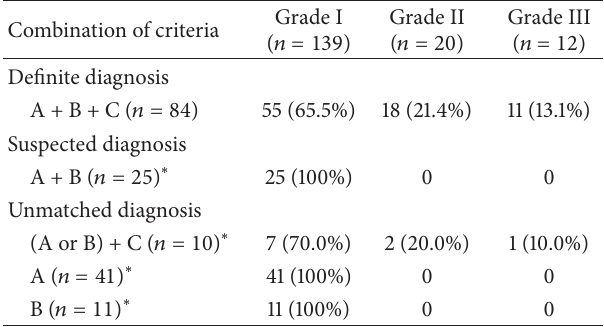
Table 2: Distribution according to severity grades based on